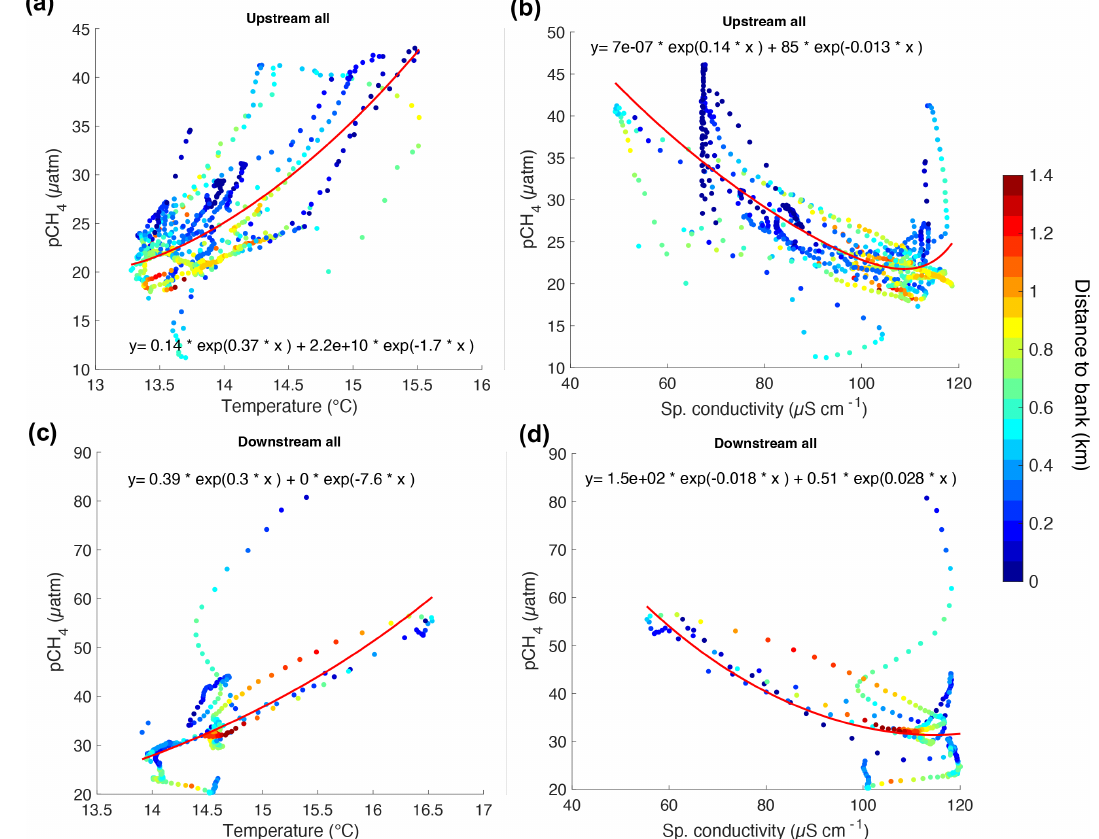
Figure 4. Correlation graphs for UP (a and b) and DOWN (c and d) transects between T , κ , and p CH 4 as a function of the distance to bank ( z in km) indicated in the color scale. Table 1. Average ± 1 standard deviation (minimum and maximum values below it) of p CH 4 , the concentration of CH 4 ( C w ), T , and κ measured along the UP and DOWN transects in key sites (S1–S5) and in the other sites of each transect. Measurements done in a tributary (Ambolikha River) and a stream (Leonid’s stream) as part of the measurements during the DOWN transect are also